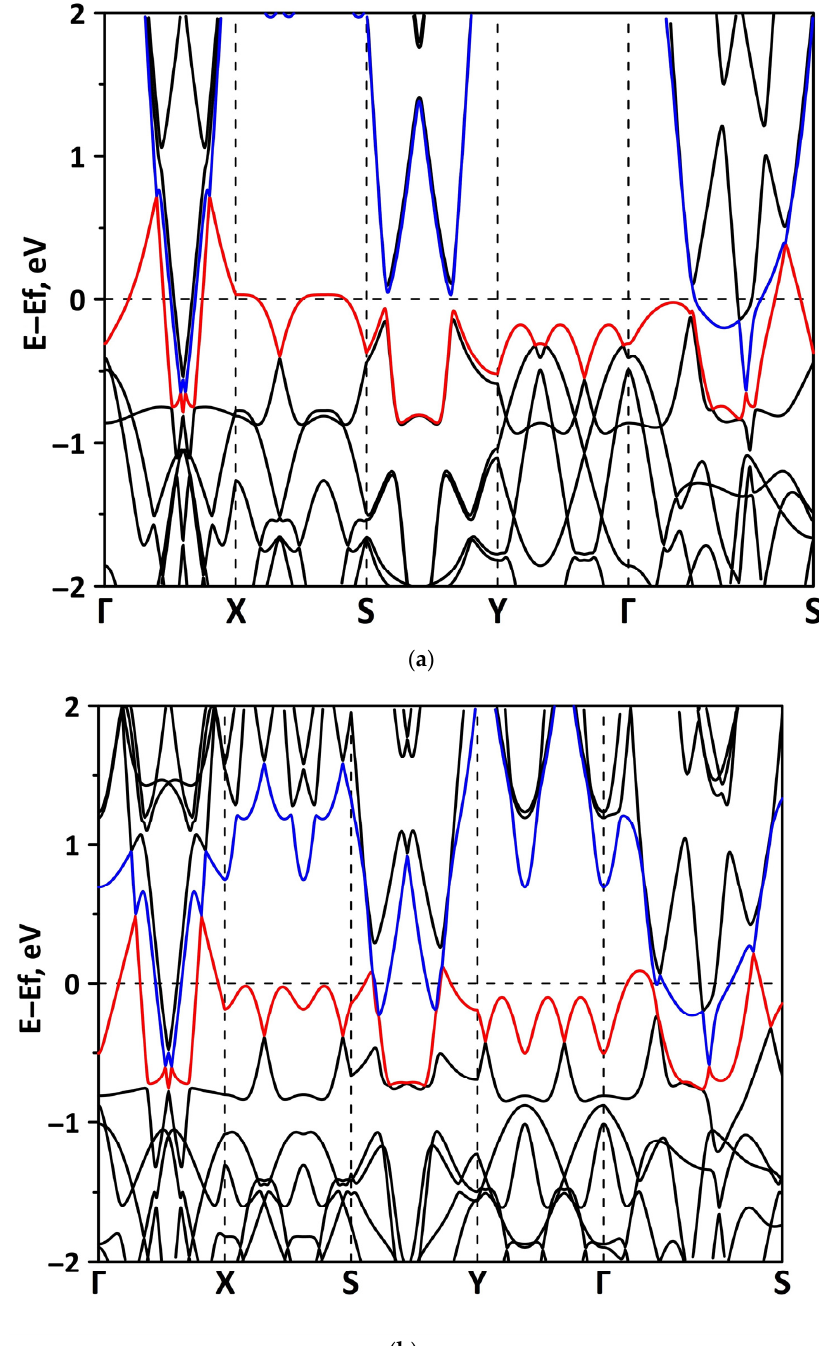
Figure 26. Fragments of the band diagrams near the Fermi level (shifted to 0 eV) of borophene/ZnO heterostructure under biaxial stretching by 2% ( a ) and 6% ( b ). The VBM is highlighted in red and the CBM is highlighted in blue.